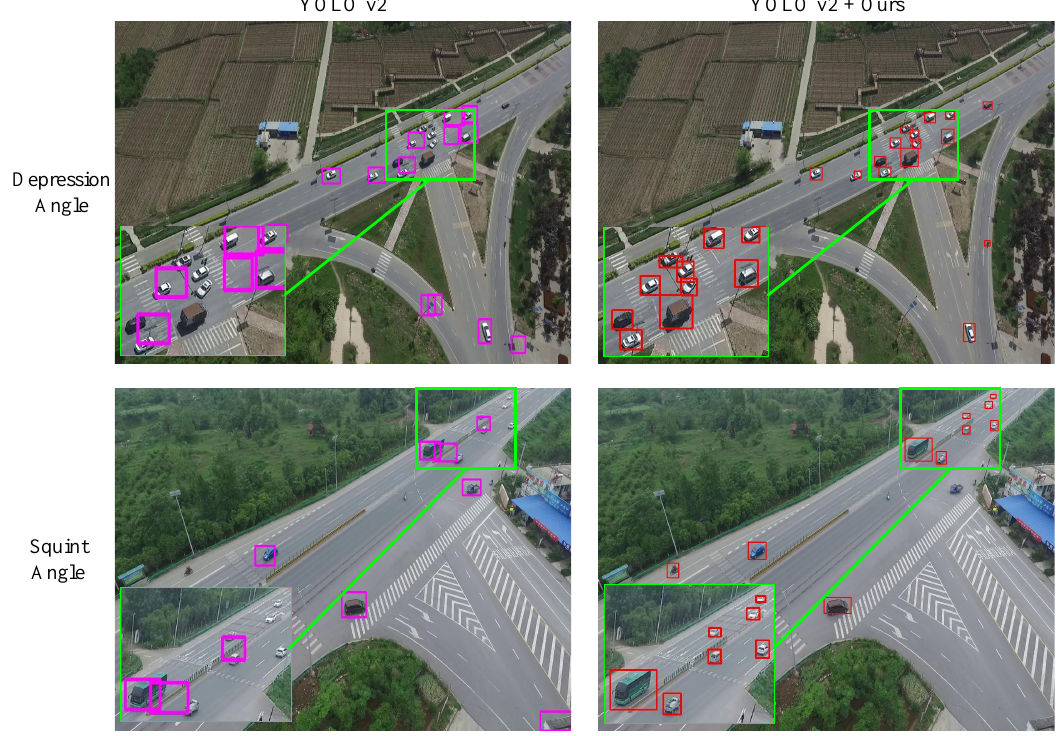
Figure 1. Some small object detection results with You Only Look Once Version 2 (YOLO v2) deep network and the proposed method. ( left ) The detection results with the YOLO v2 deep network; ( right ) The detection results with YOLO v2 and our visual detail augmented mapping approach. This figure shows that the proposed method achieves better performance in terms of both precision and